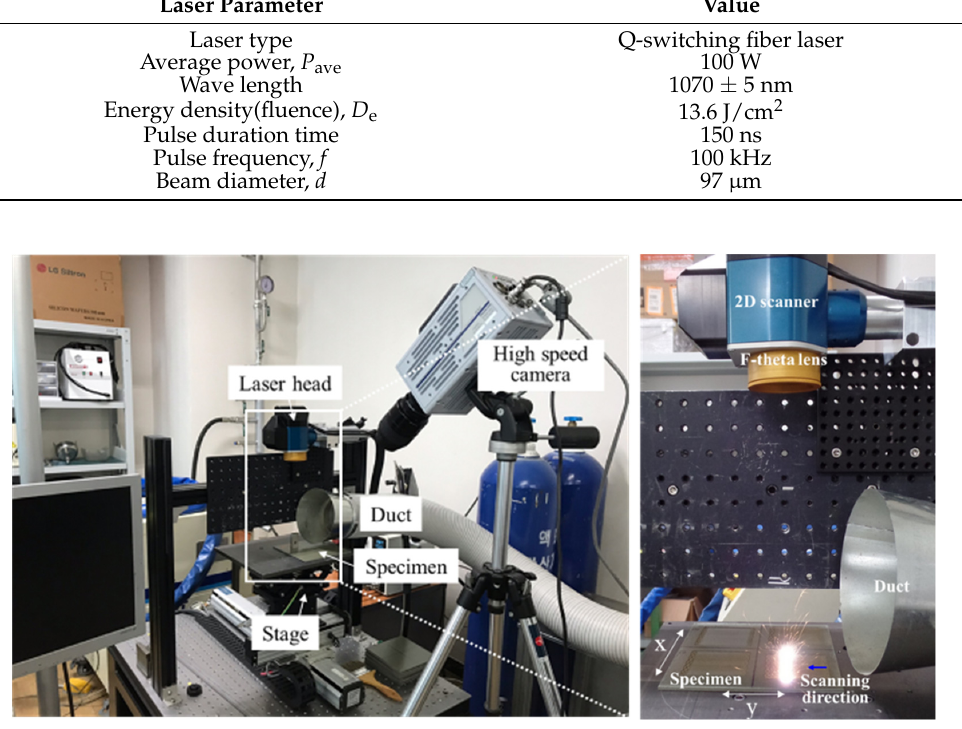
Figure 2. Experimental setup for the laser cleaning experiment using a portable fiber laser cleaning system.